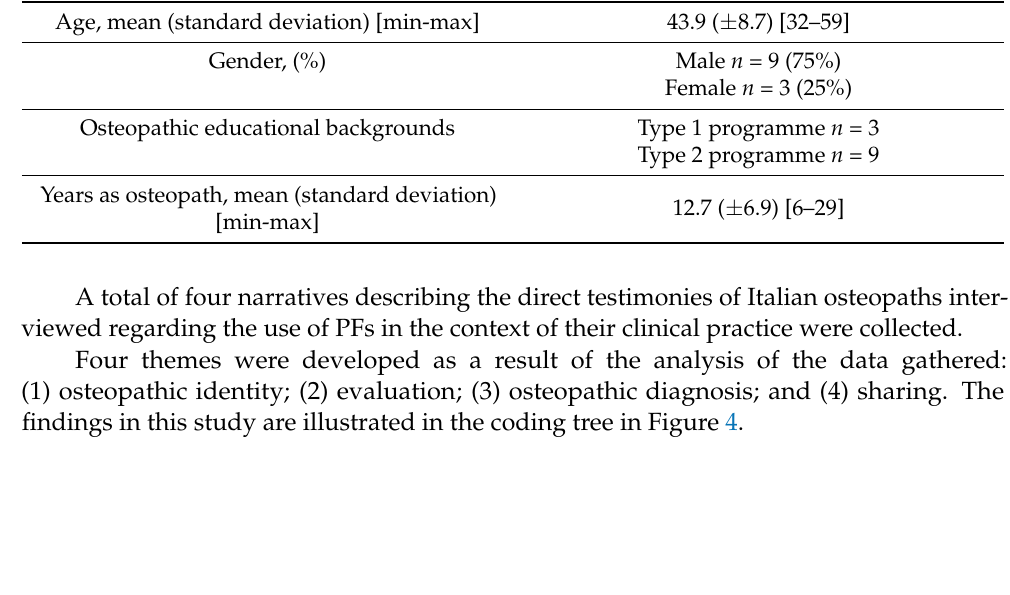
Table 2. Demographic characteristics of the